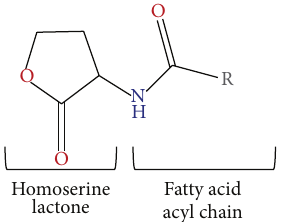
Figure 1: General structure of N -acyl homoserine lactone (AHL), where R represents the various acyl side